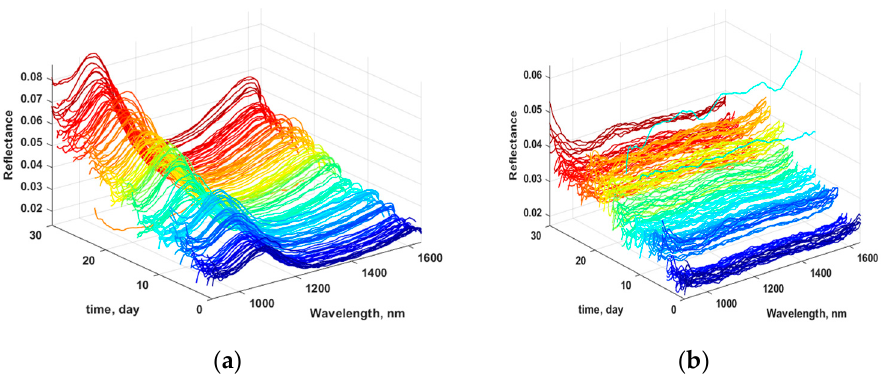
Figure 3. Development of the reflectance spectra of sample S1: ( a ) foil side excitation, ( b ) electrode side excitation. One color groups data measured during one day.